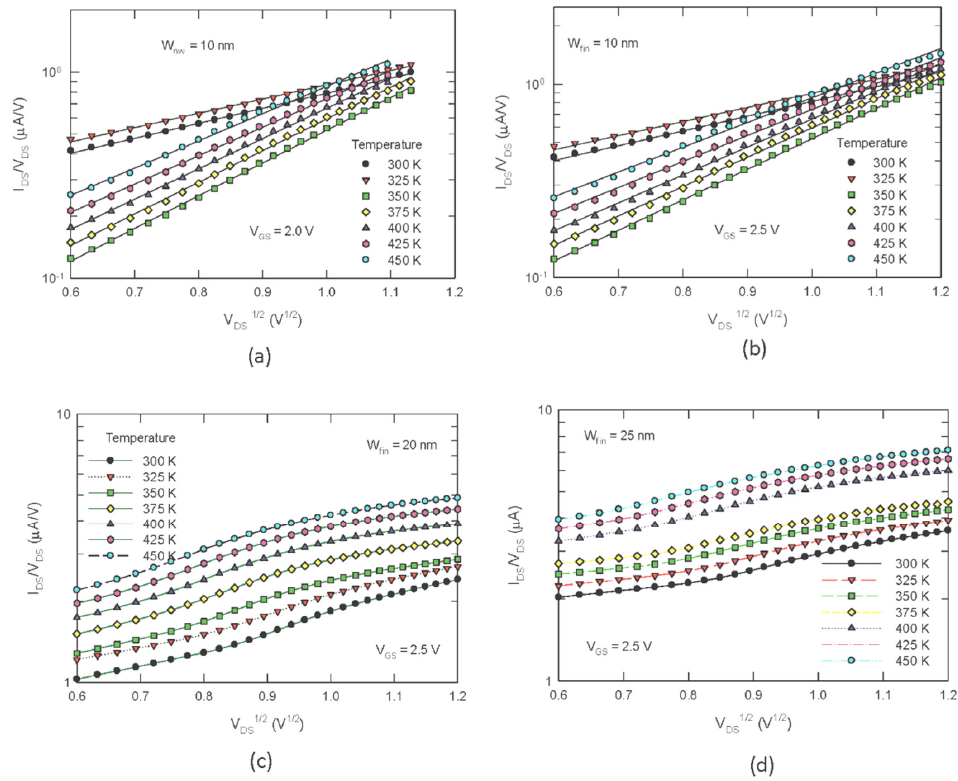
Figure 3. Poole–Frenkel plot of the superlinear drain current behaviors in the “ohmic region” at different temperatures: ( a ) nanowire width W NW = 10 nm, gate bias V GS = 2.0 V; ( b ) W NW = 10 nm, V GS = 2.5 V; ( c ) W NW = 20 nm, V GS = 2.5 V; ( d ) W NW = 25 nm, V GS = 2.5 V.